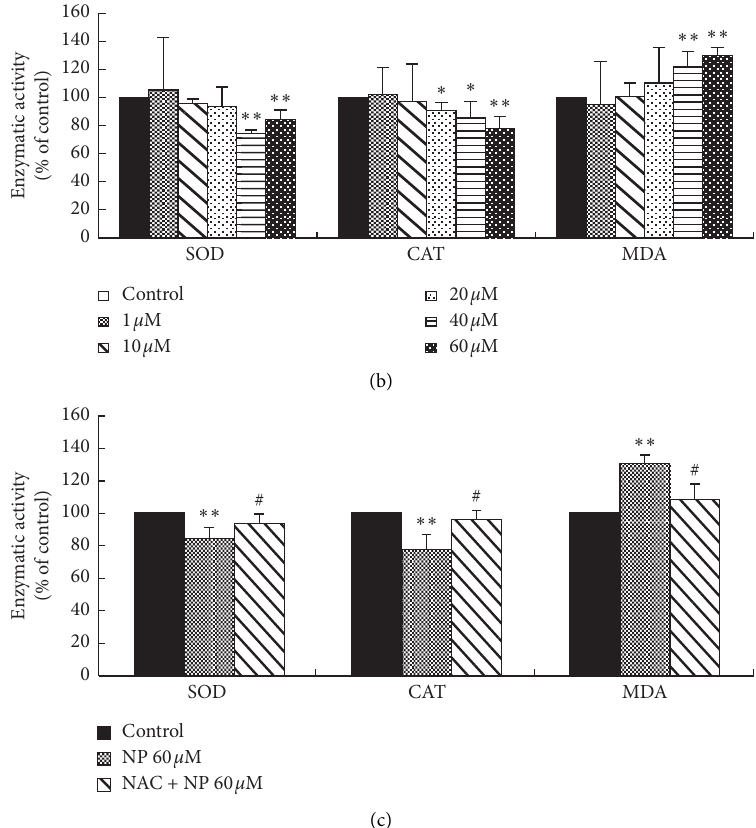
Figure 2: NP induced oxidative stress in NCTC Clone 1469 cells. (a) Intracellular ROS levels detected in cells. After exposure to NP for 12h, NCTC Clone 1469 were collected for DCFH-DA staining followed by flow cytometry analysis. (A–G) Flow cytometric plots. (H) Flow cytometric analysis result. (b) Effect of NP on intracellular SOD activity, CATactivity, and MDA content in NCTC Clone 1469. SOD activity, CATactivity, and MDA content are expressed as % of control. (c) NAC weakened NP-induced alteration of SOD activity, CATactivity, and MDA content. Results are presented as mean ± SD with triplicate measurement. ∗ P < 0 . 05, ∗∗ P < 0 . 01 versus the control group; # P < 0 . 05 versus 60 μ M NP